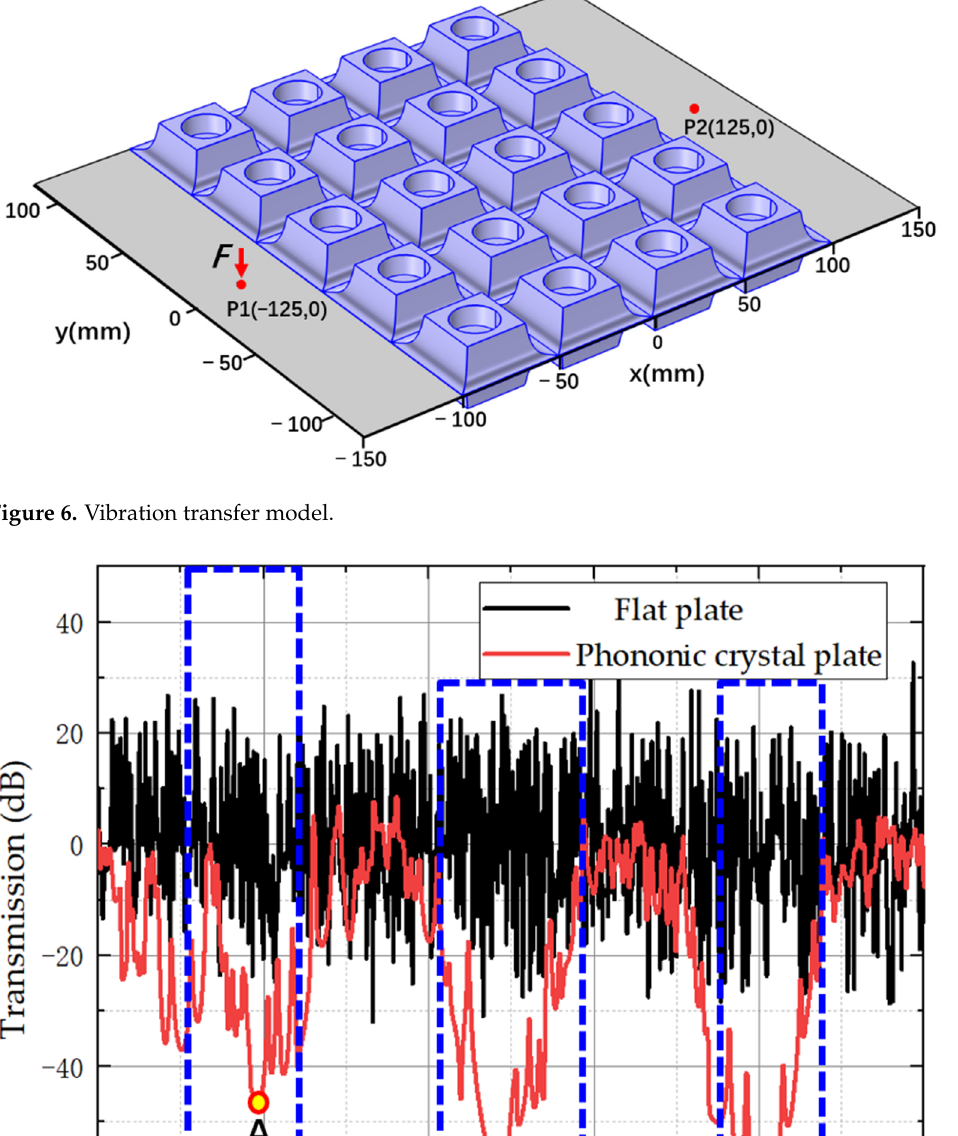
8 of 18 Figure 5. Displacement components of the eigenmodes at the A – G points in the dispersion curves in the x , y , and z directions. Table 2. Range of complete band gaps of the phononic crystal. Band Gap Name